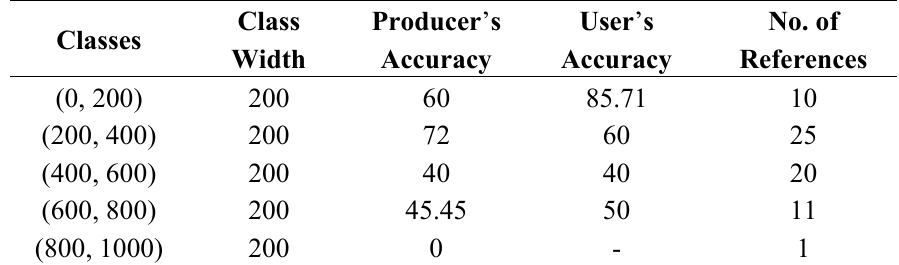
Table 6. Optimized locally-adapted class width for five timber volume classes; OAA (±95% confidence interval) (%): 64.18 (51.53, 75.53); kappa: 0.54; square sum of